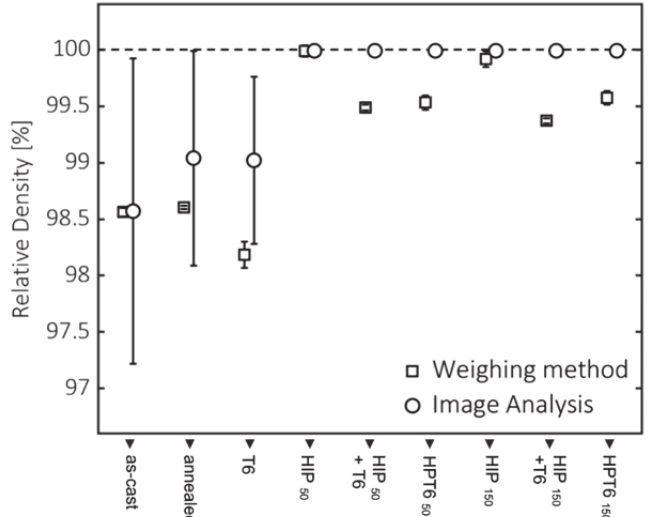
Figure 5: Comparison chart between weighing method and image analysis about density